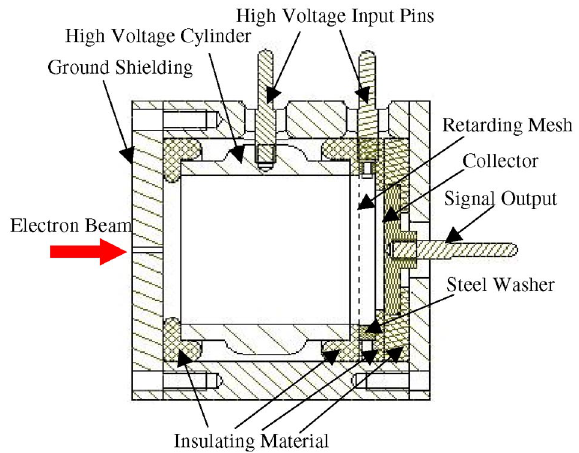
FIG. 1. (Color) Schematic of the energy analyzer with variable- focusing cylindrical electrode. The length is 4.8 cm and the diameter is 5.1 cm. The aperture size is 1 mm in